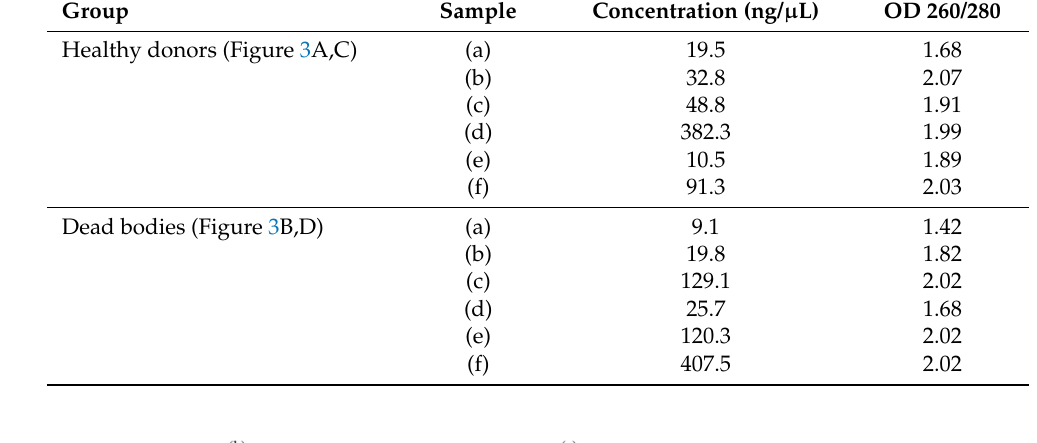
Table 1. Quantity and quality of the exosomal RNA using the exoRNeasy isolation kit.